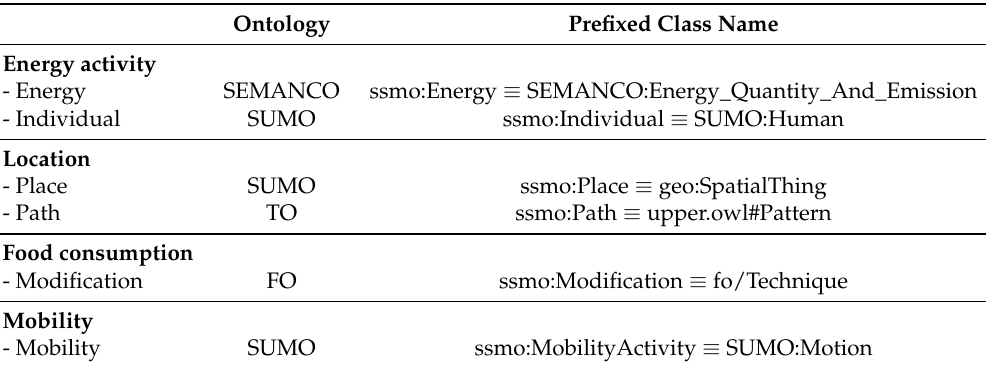
Table 3. Overview of the new entities equivalent to reused entities in the SSMO ontology.